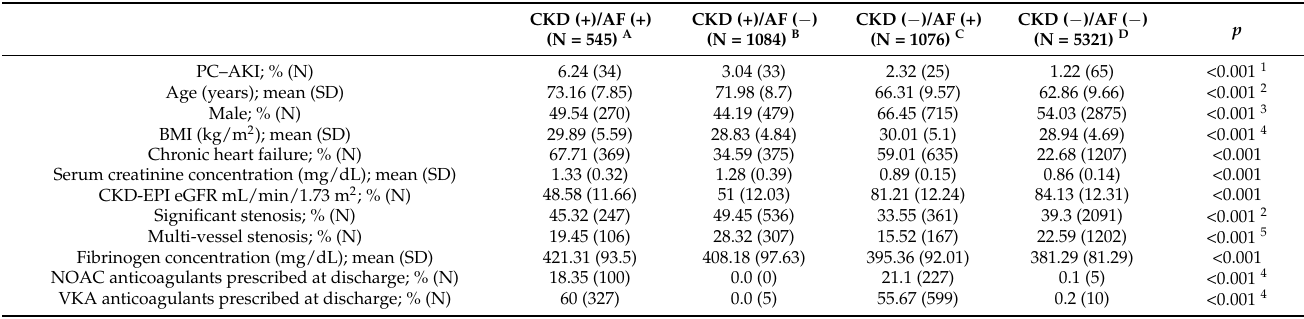
Table 2. Comparison of patients with and without chronic kidney disease and atrial